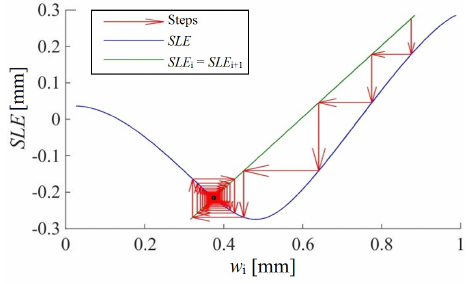
Figure 3. Schematic representation of map. the main mechanical parameters are represented.